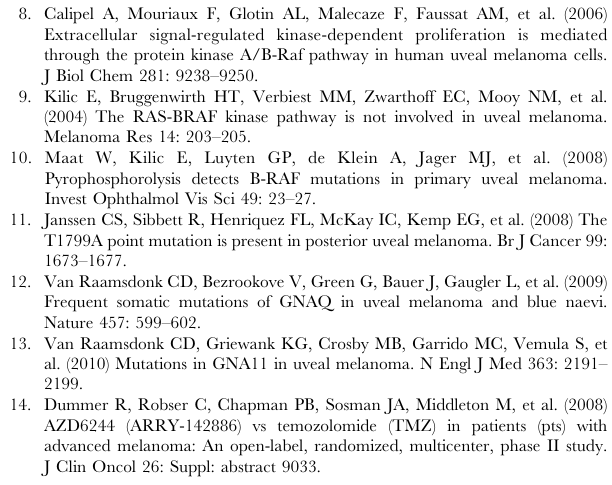
MCL-1 expression levels. Red circle , sub-G1 fraction in both the low- and high- MCL-1 expressing populations. Figure S6 AZD8055/selumetinib cooperatively down- regulates MCL-1 and upregulates BIM in an in vivo BRAF mutant xenograft model. With the xenograft experi- ment performed upon the BRAF mutant cell line OCM1A described in Figure 2 , two animals from each treatment cohort were sacrificed after the fifth drug administration and tumors were flash frozen and processed for immunoblot analysis of BIM and MCL-1 levels (Ku70 was utilized as a loading control). Each lane represents a separate animal. Figure S7 Dual pathway inhibition with selumetinib and the IGF-1R inhibitor NVP-AEW541 induces apopto- sis in OCM1A cells. Cells were treated with vehicle, 1000 nM selumetinib, 100 nM AZD8055, 1000 nM NVP-AEW541, the selumetinib/AZD8055 combination, or the selumetinib/NVP- AEW541 combination. After 24 hours, cell lysates were created and Western blot was performed. After 48 hours, flow cytometry for DNA content was performed and the percentage of sub-G1 cells was quantified. Results reflect triplicate samples for each condition. The selumetinib/NVP-AEW541 combination achieved the same dual pathway inhibition (with suppression of AKT, S6K1, and ERK phosphorylation), cooperative MCL-1 downreg- ulation, BIM upregulation, and induction of apoptosis that was observed with the selumetinib/AZD8055 combination. See the RTK array blots in Figure S4B confirming that NVP-AEW541 inhibits IGF-1R phosphorylation alone and in combination with selumetinib in these conditions. Error bars, SE. Figure S8 PTEN levels and the susceptibility to the selumetinib/AZD8055 combination. A, Protein expression of PTEN and several other phospho-proteins in the six uveal and two cutaneous melanoma (PTEN-negative Mel 133 and PTEN- positive Mel 32) cell lines was examined by Western blot. B, siRNA mediated suppression of PTEN in the GNAQ cell line 92.1 does not significantly change the impact of the selumetinib/ AZD8055 combination upon the targeted pathways or apoptosis. Cells were transfected with pooled siRNA constructs targeting PTEN or unrelated control constructs for 48 hours and then